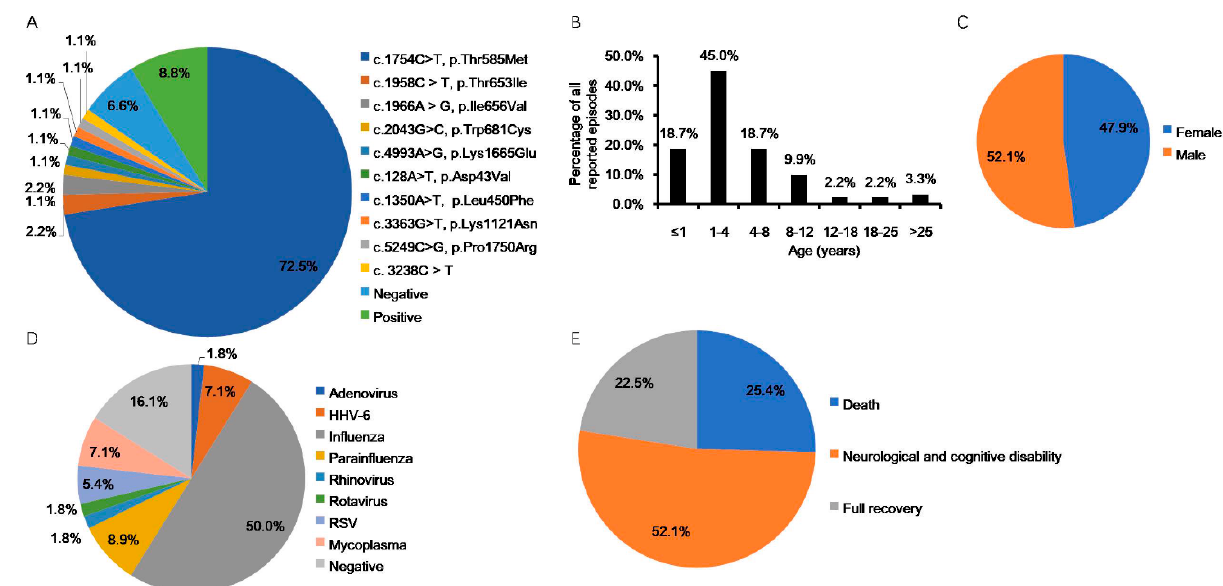
Figure 1. Statistical analysis of clinical information of ANE1 in 96 patients based on Table 1. ( A ) Percentage of RANBP2 variants detected in all the reported cases. Negative indicates that no mutations were found in the coding region of the RANBP2 gene in the familial or recurrent ANE patients, but the analyses did not preclude the possibility of an unidentified intronic mutation. Positive indicates that mutations were found in the coding region of the RANBP2 gene, but the exact sites of the mutations were unclear. ( B ) Age distribution of all reported ANE1 episodes except for the ones without clear age information. ( C ) Gender distribution of all reported ANE1 cases. ( D ) Percentage of infectious agents detected in all reported episodes except for the ones without clear infectious agent information. ( E ) Percentage of outcomes in all the reported cases except for the ones without clear outcome information. List of abbreviations: ANE, acute necrotizing encephalopathy; RanBP2, Ran Binding Protein 2; HHV-6, human herpes virus-6; RSV, respiratory syncytial virus.